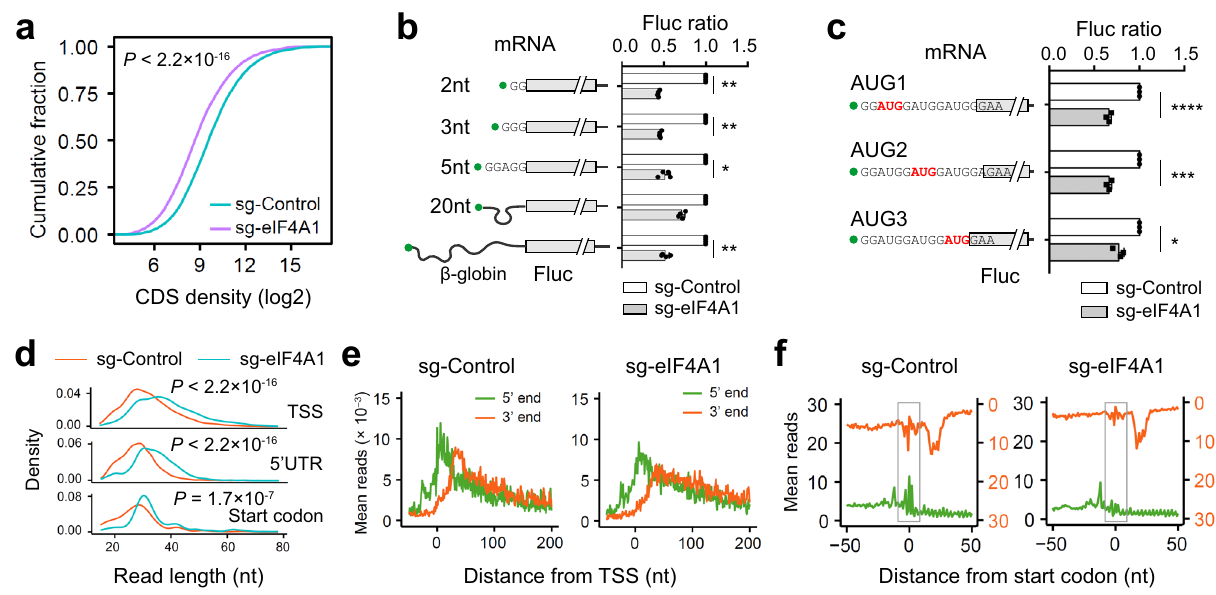
Fig. 4 The RNA helicase eIF4A1 promotes free scanning of the PIC. a Evaluation of global translation by Ribo-seq in MEF cells with or without eIF4A1 knockdown. Ribosome densities on individual transcripts were normalized to the number of mitochondrial reads and plotted as cumulative fractions. b Translation ef fi ciency of Fluc mRNA reporters with ultra-short 5 ʹ UTR in MEF cells with or without eIF4A1 knockdown. Fluc activities in the absence of eIF4A1 were normalized to the control. Error bars: mean ± SEM; n = 3 biological replicates. Two-tailed t -test, * p < 0.05; *** p < 0.001. c . Translation ef fi ciency of Fluc mRNA reporters containing 3 AUG codons near the 5 ʹ end in MEF cells with or without eIF4A1 knockdown. Fluc activities in the absence of eIF4A1 were normalized to the control. Error bars: mean ± SEM; n = 3 biological replicates. Two-tailed t -test, * p < 0.05; *** p < 0.001; **** p < 0.0001. d Comparison of read length distribution in cells with or without eIF4A1 knockdown. Reads mapped to TSS, 5 ʹ UTR, or start codons are plotted separately. e Aggregation plots of 5 ʹ end (green) and 3 ’ end (red) of reads on mRNAs aligned to TSS using eIF3-seq data sets obtained from cells with or without eIF4A1 knockdown. f Aggregation plots of 5 ʹ end (green) and 3 ʹ end (red) of reads on mRNAs aligned to start codons using eIF3-seq data sets obtained from cells with or without eIF4A1 knockdown. Highlighted squares indicate upstream footprints (3 ’ end of reads) and downstream footprints (5 ʹ end of reads). Source data are provided as a Source Data fi